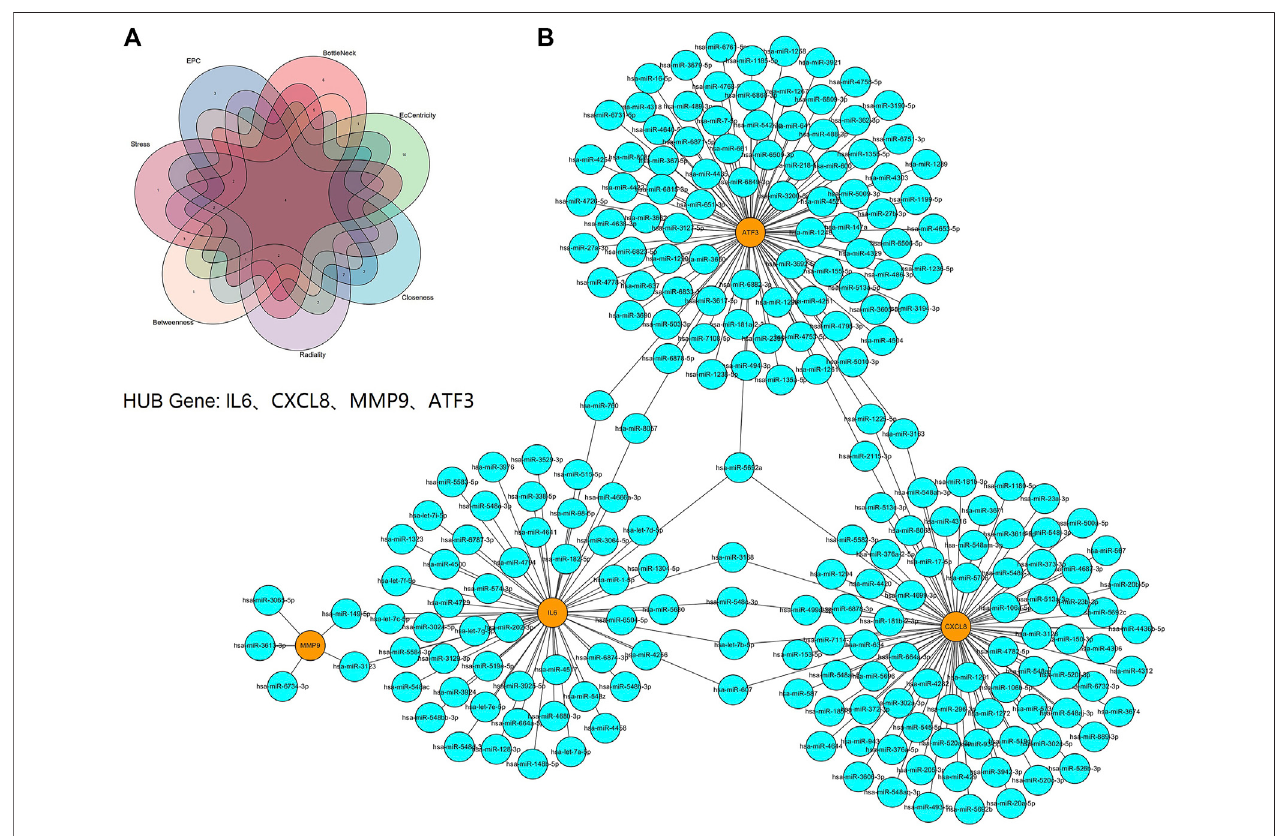
FIGURE 7 | Screening of HUB genes and the co-expressed network of mRNAs and target miRNAs. (A) The Venn diagram of four hub genes identi fi ed by seven algorithms of cytoHubba. (B) The mRNA-miRNA co-expressed network was constructed by Cytoscape including 228 nodes and 237 edges. One node represents a mRNA or miRNA, while one edge represents one interaction of mRNA and miRNA. Yellow nodes represent the hub genes, and blue nodes represent miRNAs.